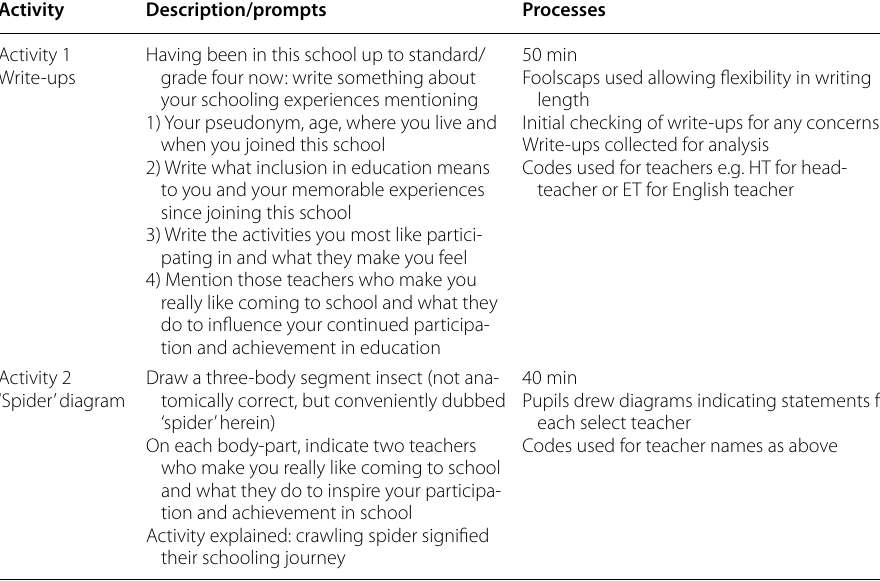
Table 1 Children’s creative